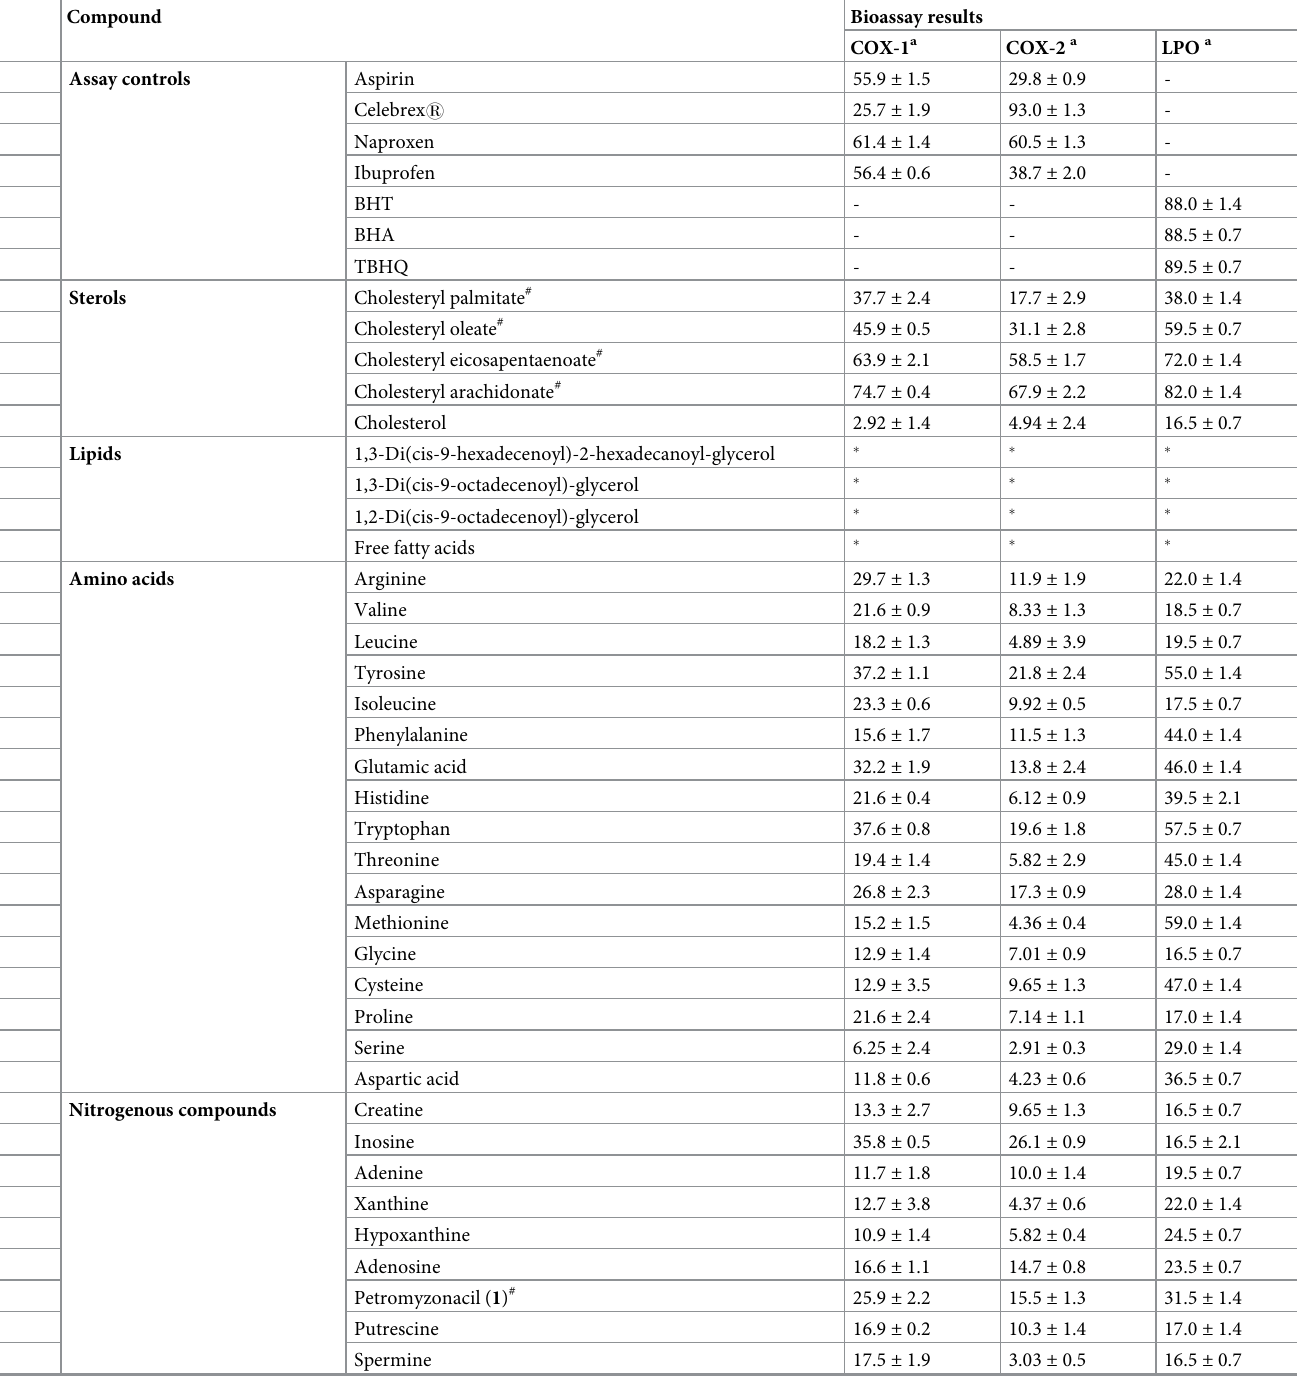
Table 2. Percent antiinflammatory (COX-1 and -2) and antioxidant (LPO) inhibitory activities of compounds isolated from sea lamprey lipophilic and water-solu- ble fractions tested at 25 μ g/mL concentration.